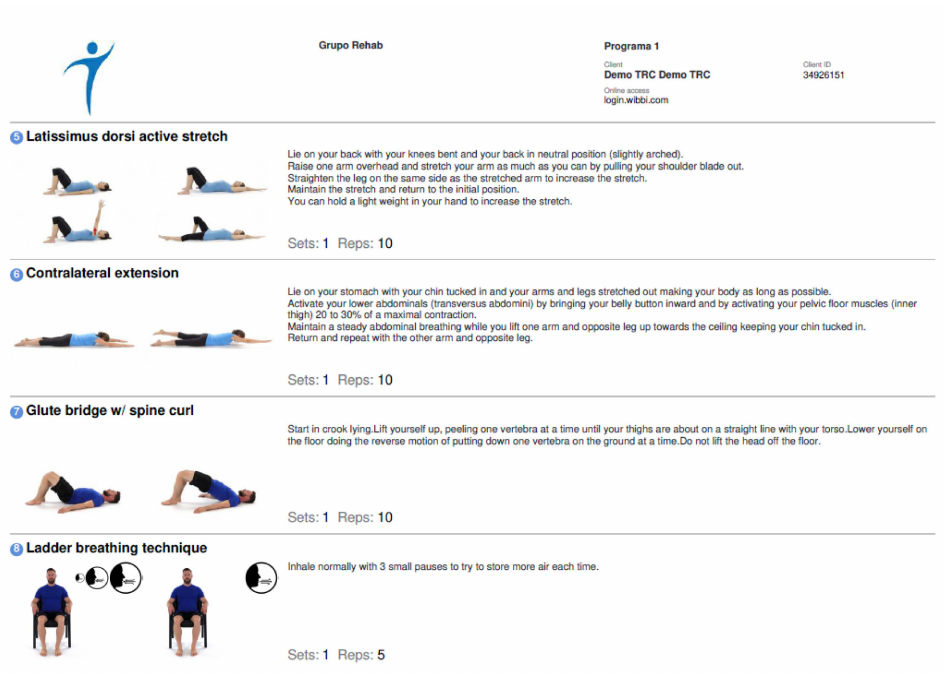
Figure 2. Example of an individualised exercise